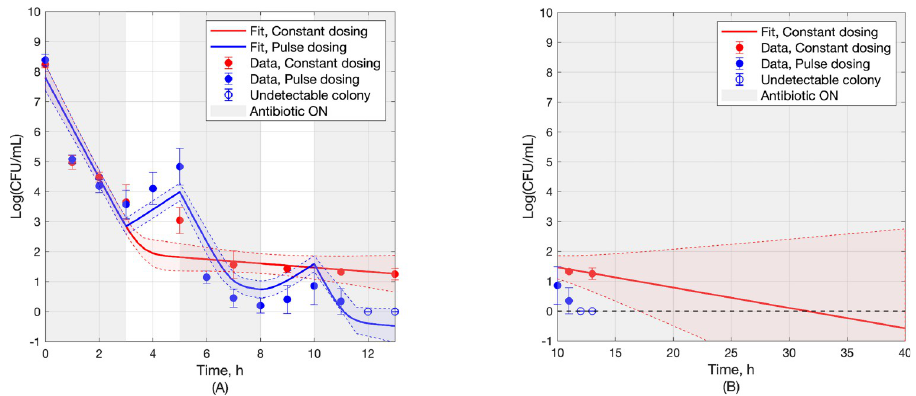
Fig 6. (a) Experimental data and model fit for bacterial population over time, resulting from constant dosing (red) and uniform pulse dosing at ratio t off / t on = 2/3 (blue). The hollow blue circles at 12h and 13h are set to 0 by convention, to indicate undetectable colony forming units (CFU). (b) Fitted model projection for the outcome of constant dosing to reach 0. 68%-confidence bands (1 standard error) are